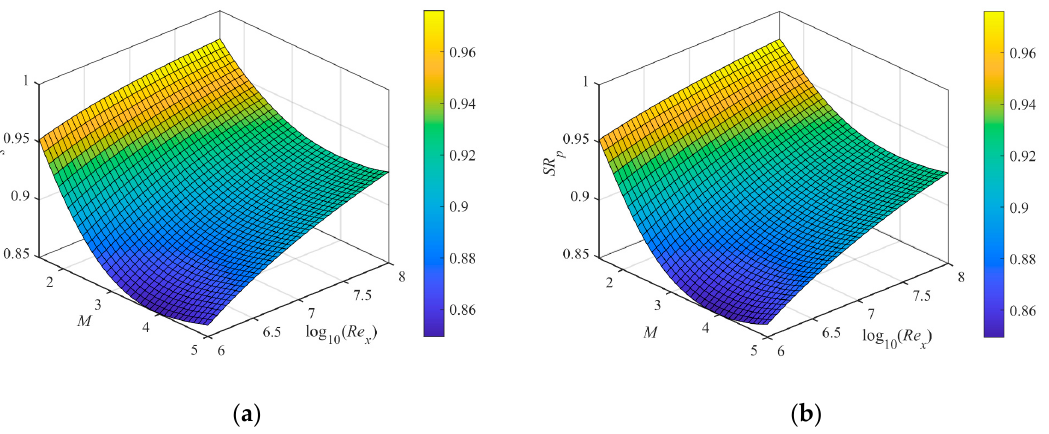
Figure 6. ( a ) s SR of the turbulence density proxy model; ( b ) p SR of the distortion prediction Figure 6. ( a ) SR s of the turbulence density proxy model; ( b ) SR p of the distortion prediction model.